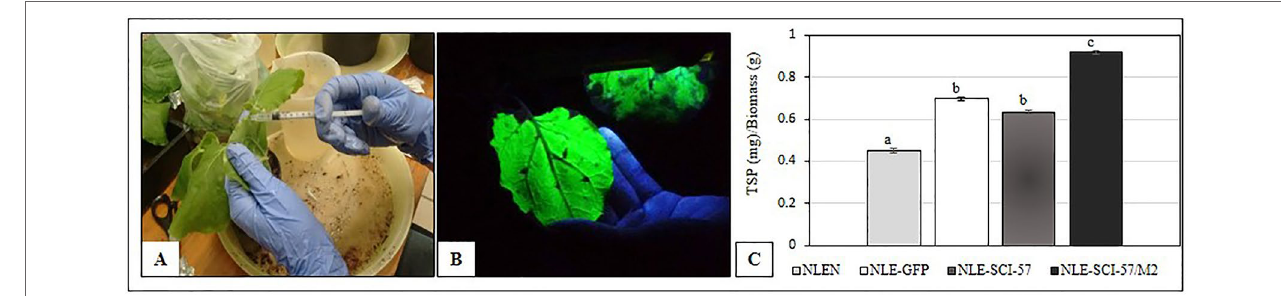
FIgUrE 1 | (A) Syringe agroinfiltration of Nicotiana benthamiana leaves with Agrobacterium tumefaciens . (B) Transient expression of GFP in leaves of N. benthamiana 4 days after the agroinfiltration. (C) Bradford analysis of the total soluble proteins (TSP). Leaves were harvested four days post-agroinfiltration. Results are presented as the mean ± S.D. of three independent experiments in triplicate. Lowercase letters indicate significant differences according to the Mann-Whitney test ( p ≤ 0.05). NLEN, N. benthamiana -leaf extract from non-agroinfiltrated plants; NLE-GFP, N. benthamiana -leaf extract from GFP expressing plants; NLE-SCI-57, N. benthamiana -leaf extract from SCI-57 expressing plants; NLE-SCI-57/M2, N. benthamiana -leaf extract from SCI-57 expressing plants and co-expressing M2.